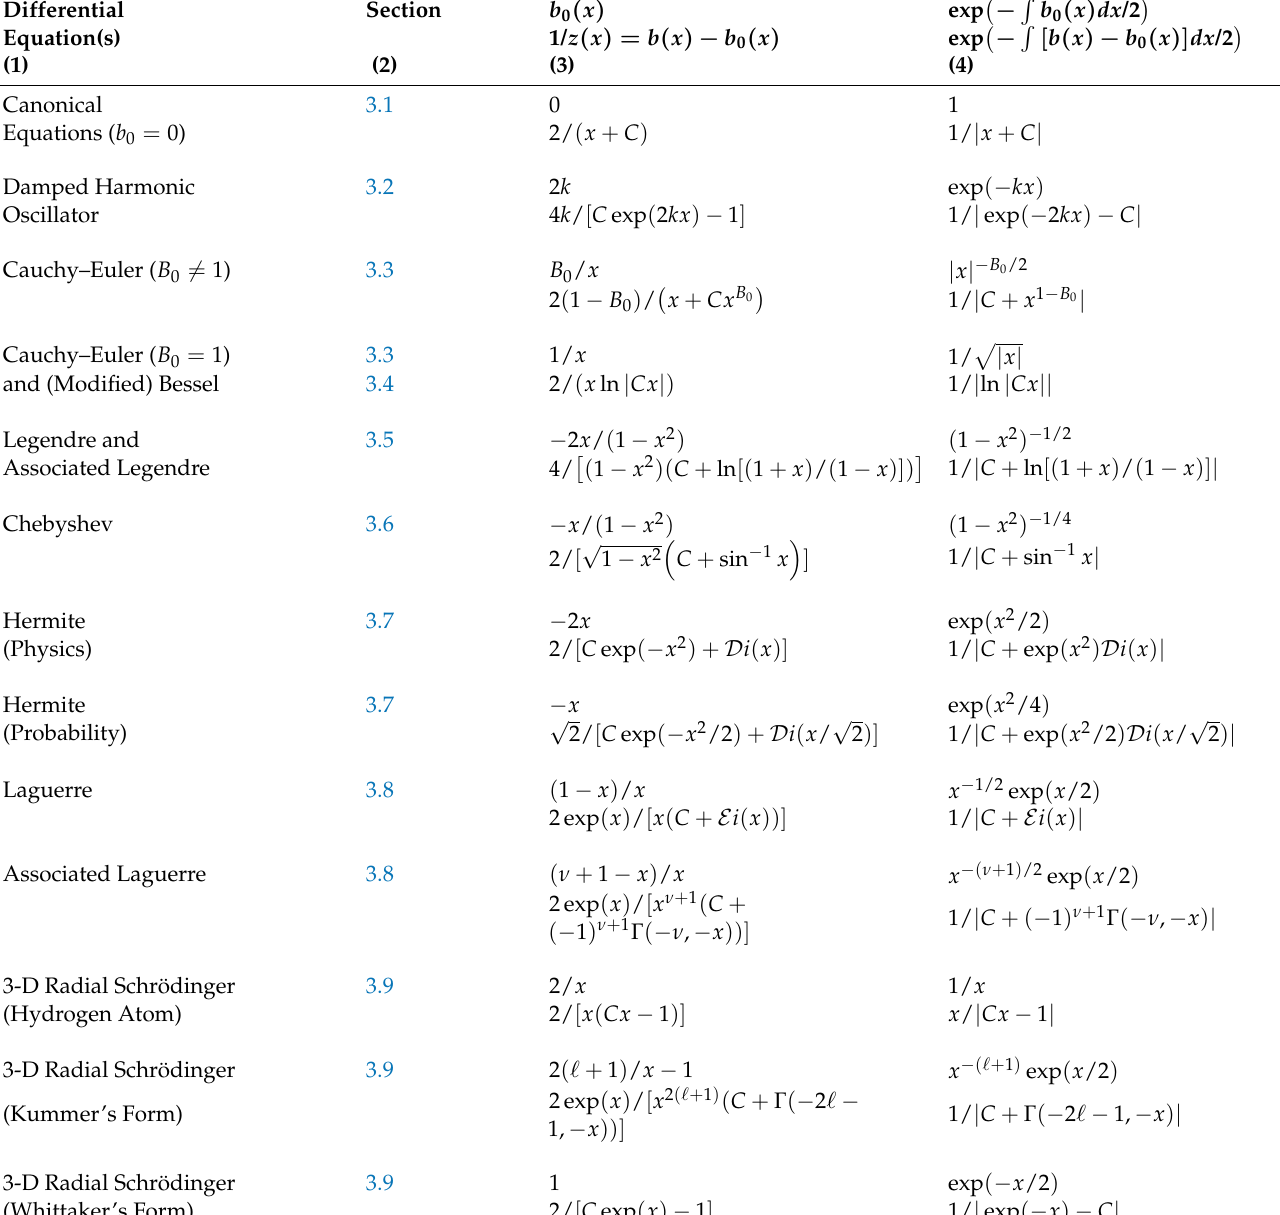
Table 1. Exponential factors and 1/ z terms that appear in the solutions (4) and (7) of the OSLH differential Equations (1) and (5) with c = c 0 , due to transformations to the canonical form